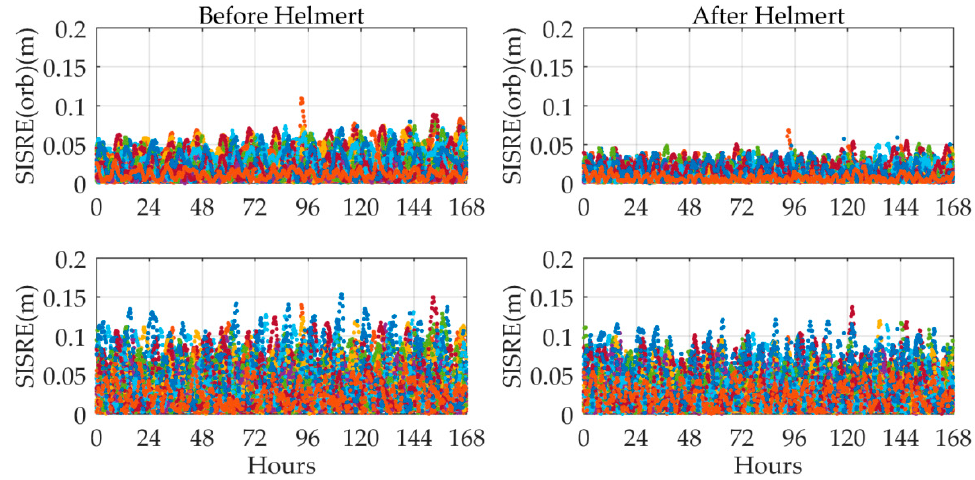
Figure 7. Seven-day signal-in-space range errors of MADOCA real-time products for all available GPS satellites relative to IGS final products from 11 November 2018 to 17 November 2018.